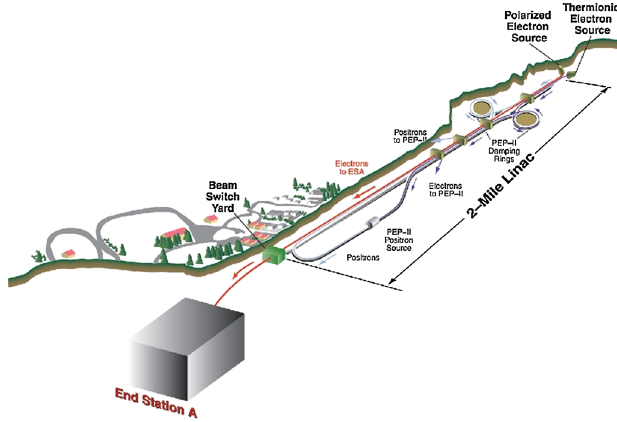
FIG. 1. (Color) A cartoon showing the SLAC linac, and the